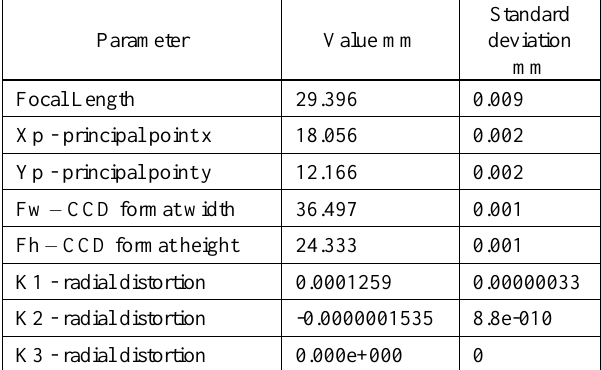
Table 4. Self-calibration of Canon EOS 5D Mk II